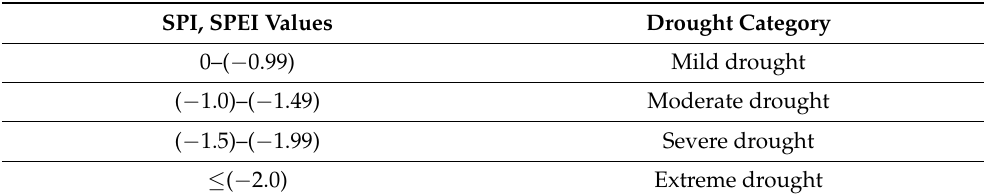
Table 3. Limit values for standardized precipitation index (SPI) and standardized precipitation evapotranspiration index (SPEI). Data from